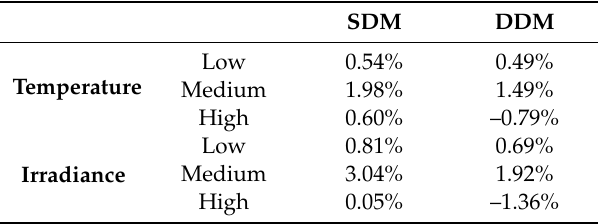
Table 2. Normalized mean bias error for SDM and